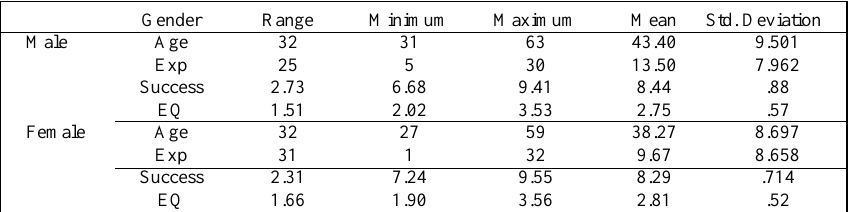
Table 5 Descriptive Statistics of Male and Female